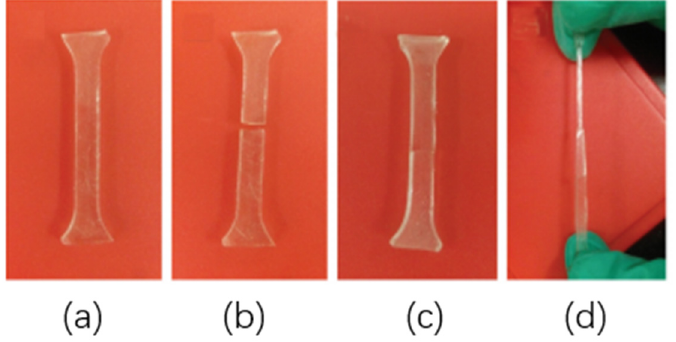
Figure 9. Photos of elastomer self-repair. ( a ) Original sample ( b ) After cutting off ( c ) After self-healing ( d ) Artificial constant pulling .